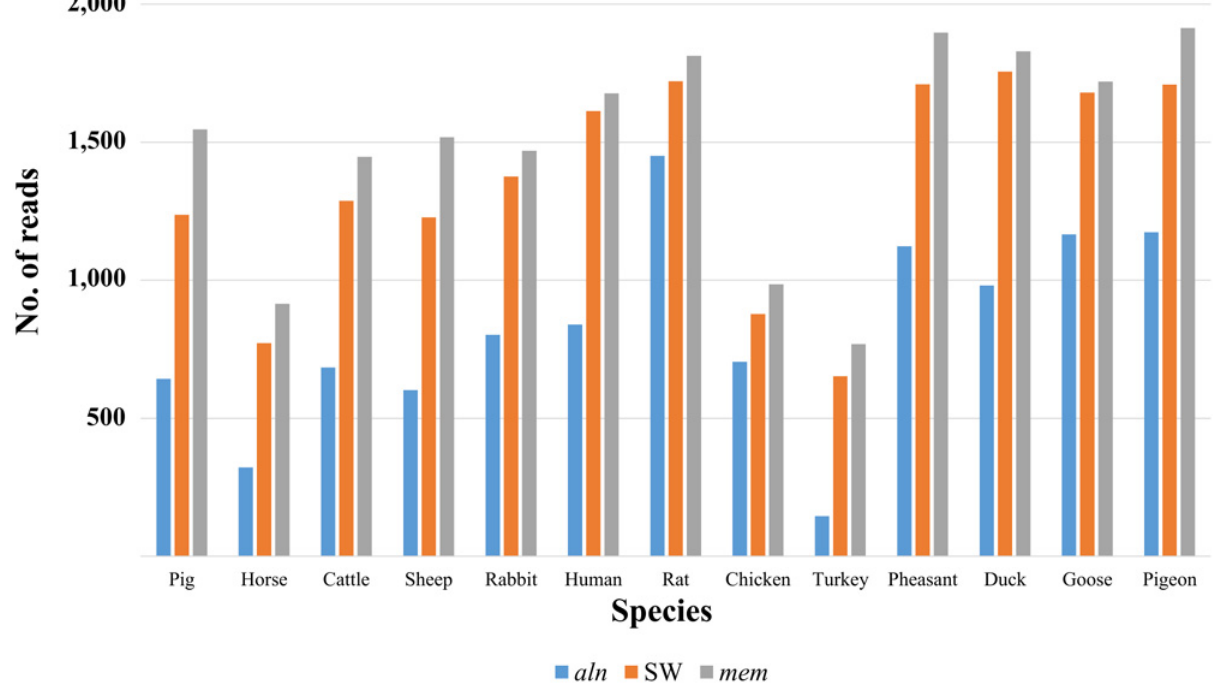
Fig 1. Number of reads mapped by the three algorithms ( aln , SW and mem ) for each species. The products obtained from the three primer pairs after the filtering step of sequence data obtained from library 1 were considered together.